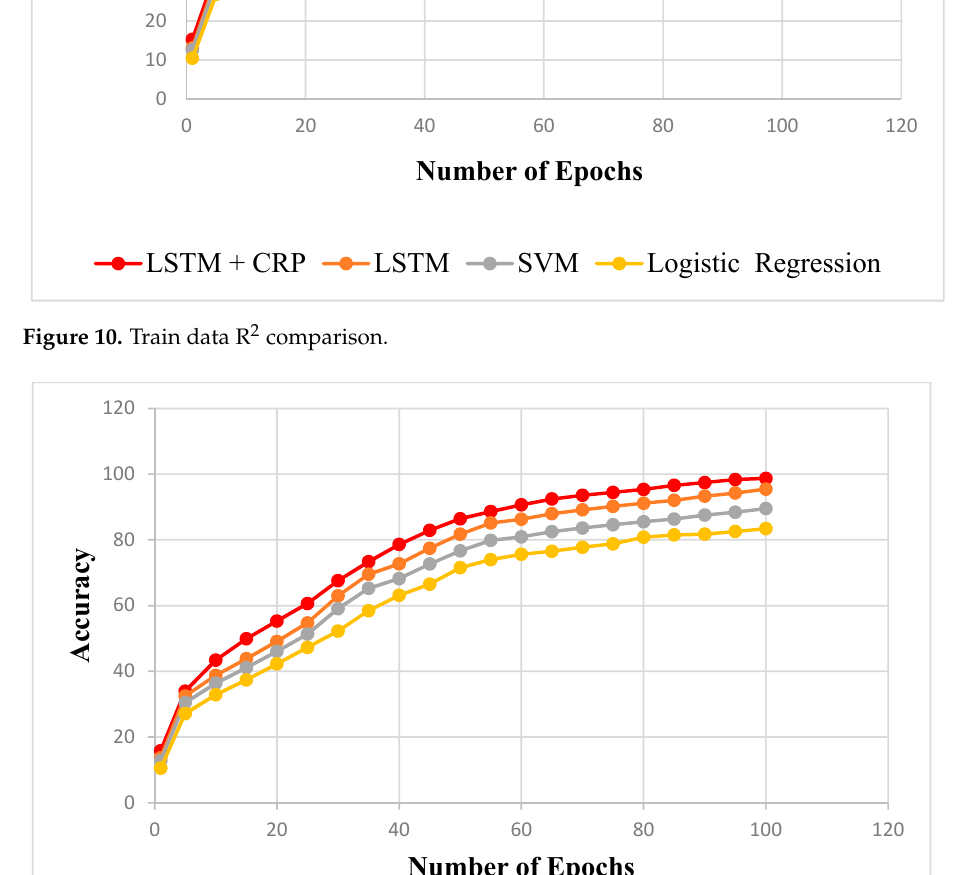
Figure 11. Test data R 2 comparison. Table 6. Multiple epochs of testing data R 2 vs. various techniques.